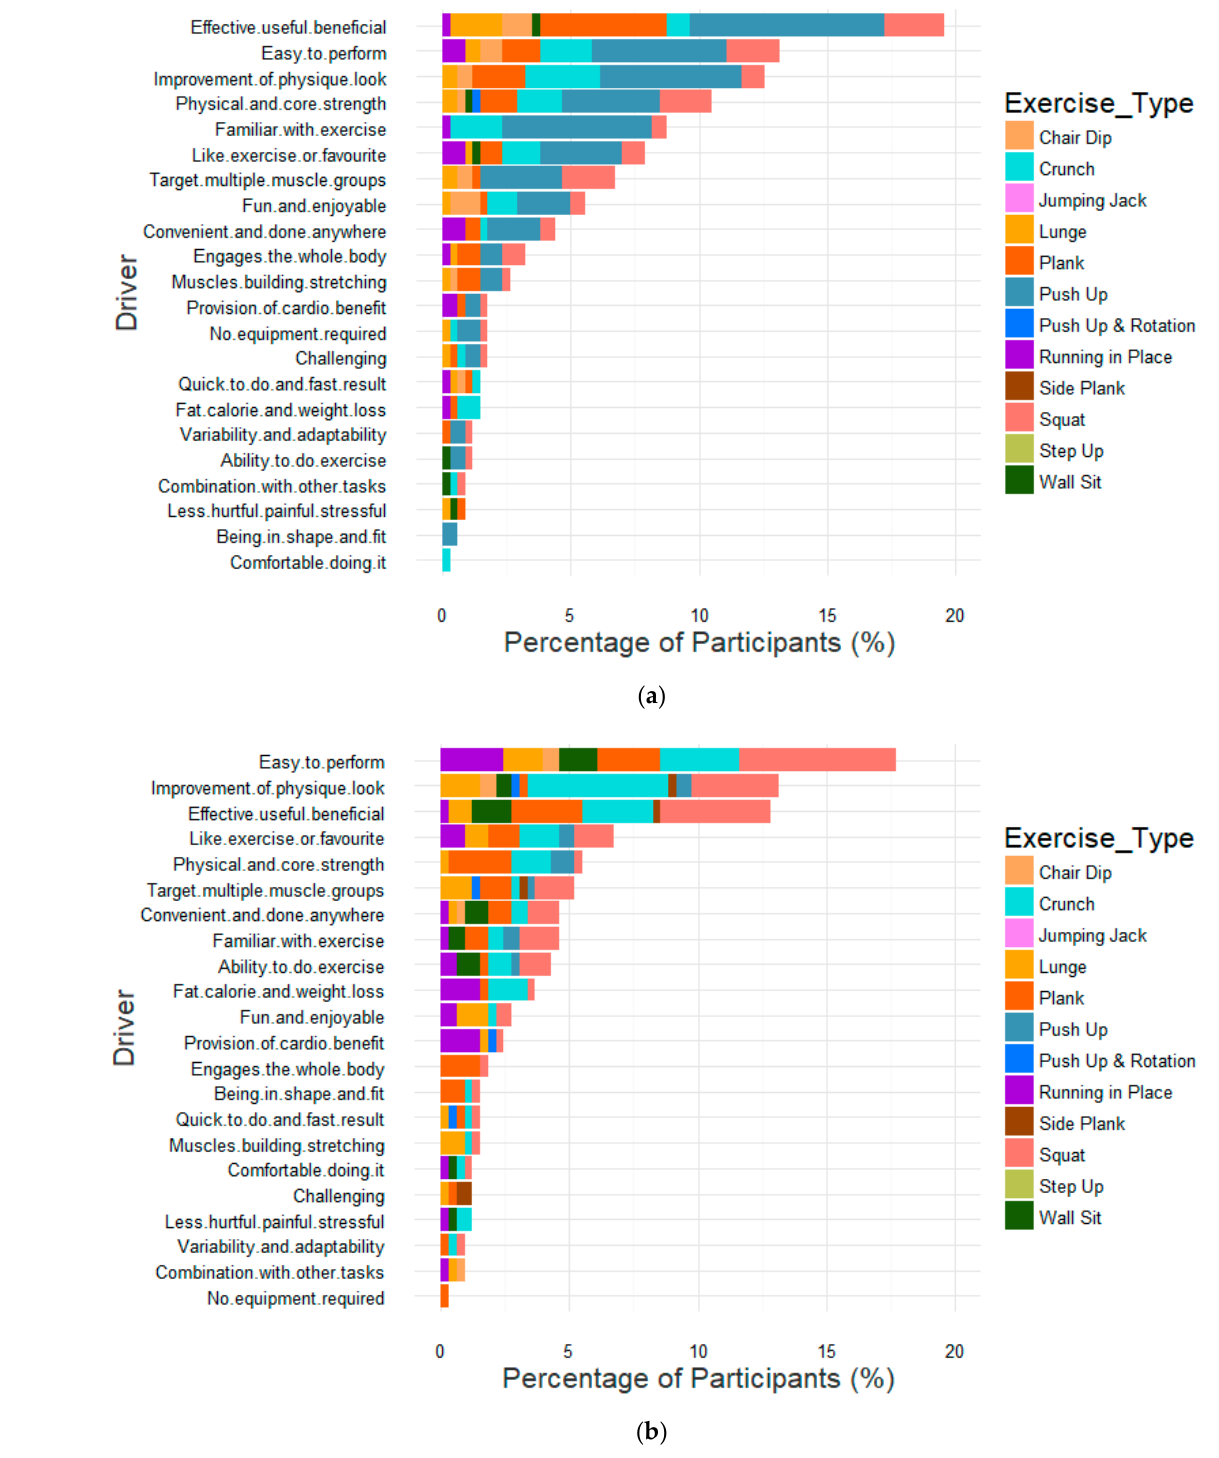
Figure 4. ( a ) Drivers of males’ most preferred exercise types. ( b ) Drivers of females’ most preferred exercise